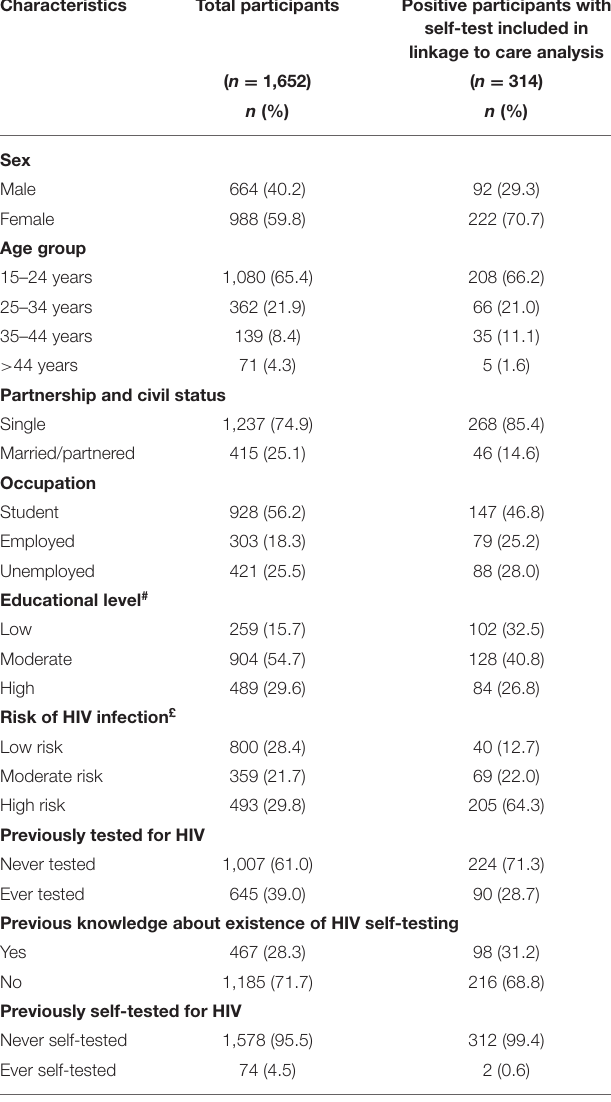
TABLE 1 | Characteristics of 1,652 participants using the HIV self-test and 314 participants with positive results.